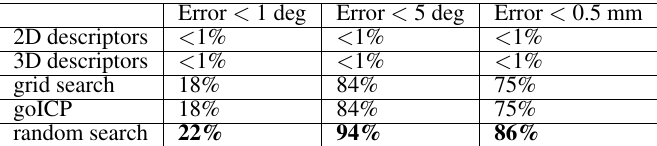
Figure 6. Translation error (absciss axis) and rotation error (ordinate axis) with different sizes of border exclusion (the radius is in cm). Each point represents the mean of error on pairs of coin with 100 random initializations. We can remark that Point to Point ICP doesn’t converge. Point to Plane ICP converges only if we exclude the border but if we exclude too much, it doesn’t work. The best radius in our experiments is 8 mm.